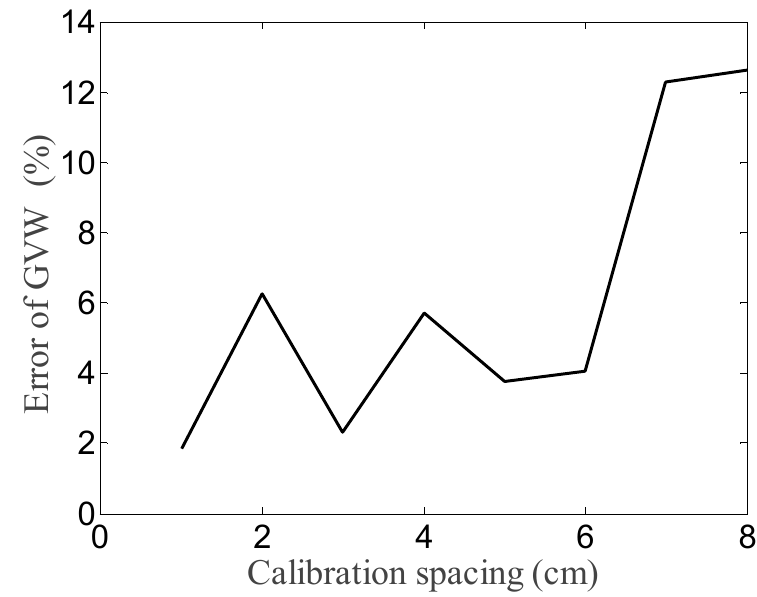
Figure 19. Identified error of the GVW under different calibration spacing d .